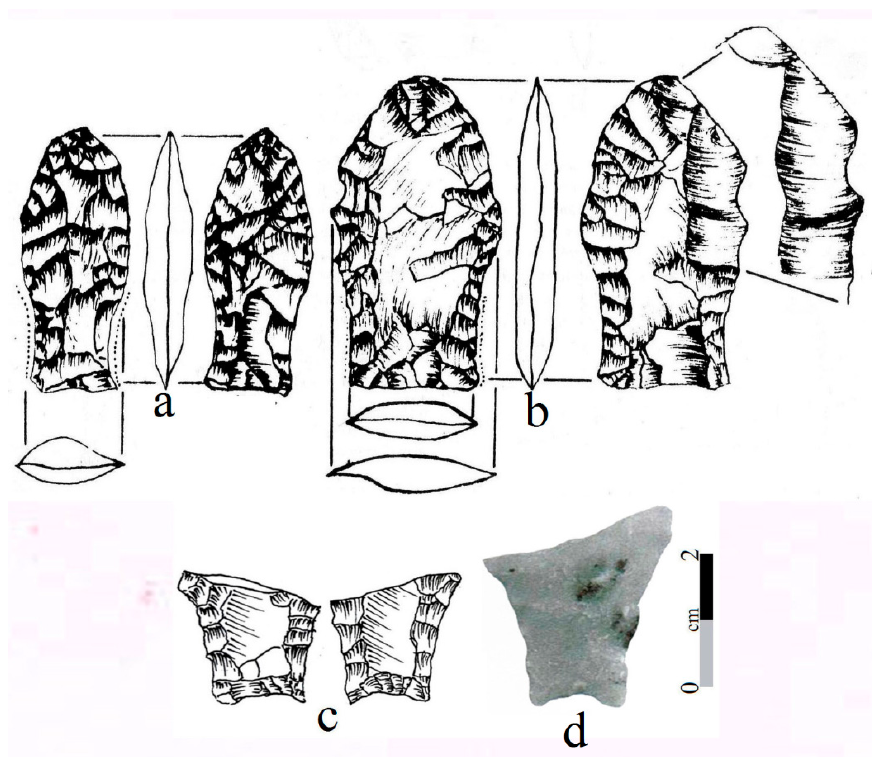
Figure 13. Fell points found in the Paleoamerican level from CM. ( a , b ) from Nami’s excavation, ( c ) approximate drawing based on photograph after Figure 14 of [29], ( d ) from the Epullán locality.